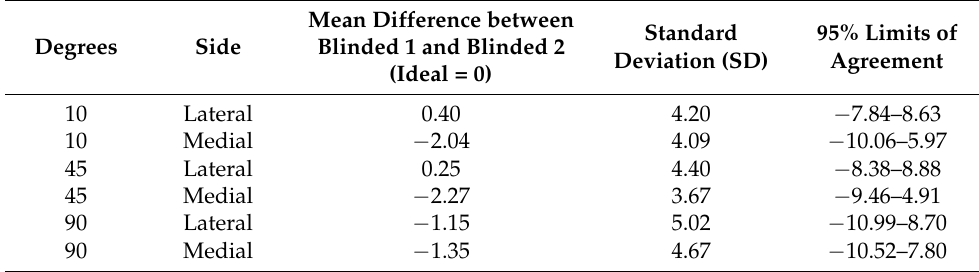
Table 2. Intraclass correlation coefficients for Scenario A.